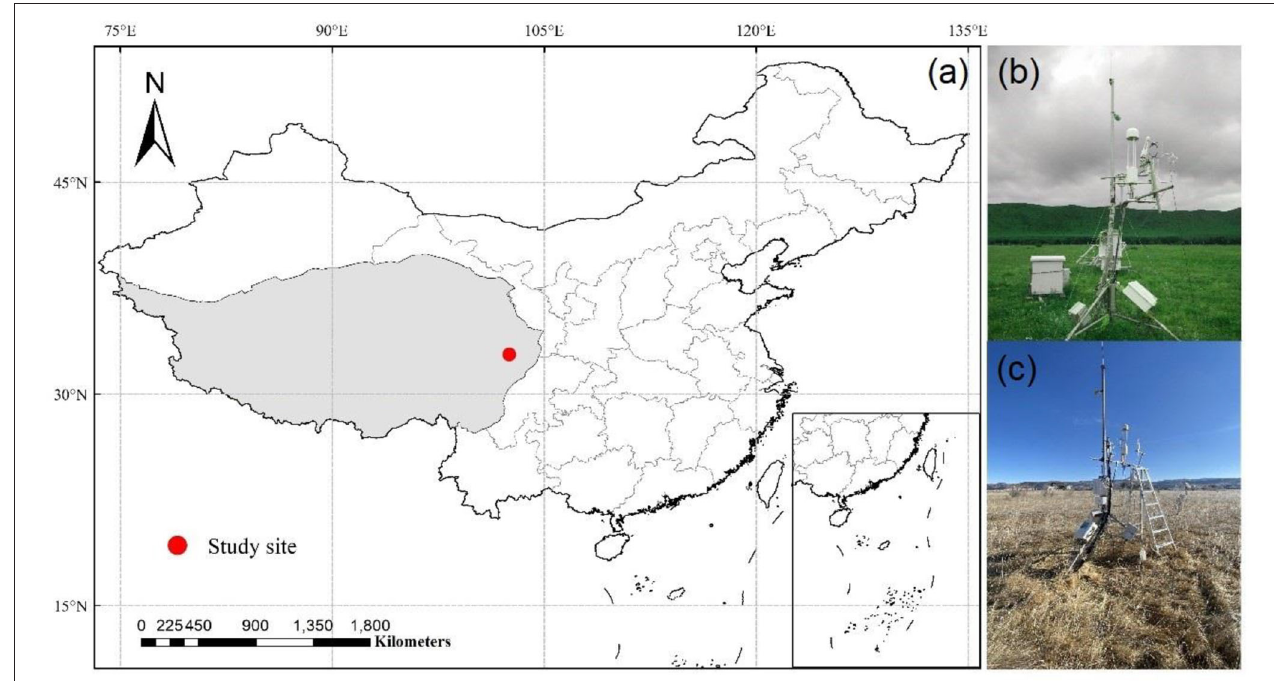
FIGURE 1 | (a) Study site on the Tibetan Plateau and the eddy covariance measurements during the growing season, (b) and non-growing season, (c) at our study